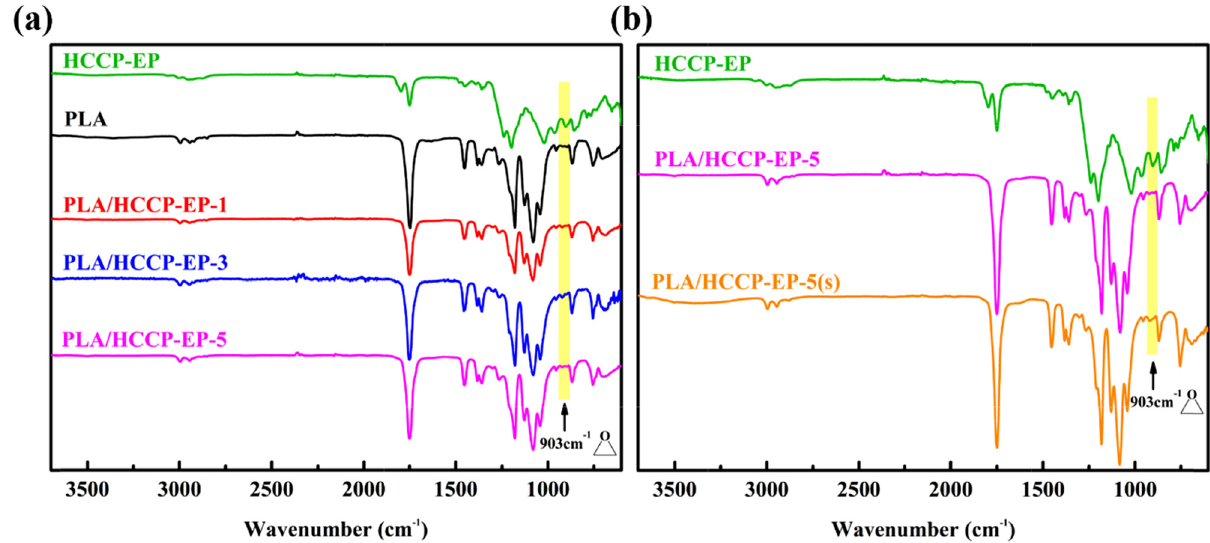
Figure 3: ( a ) The FT - IR of PLA/HCCP - EP blends. ( b ) The FT - IR of PLA/HCCP - EP - 5 and PLA/HCCP - EP - 5 ( s )